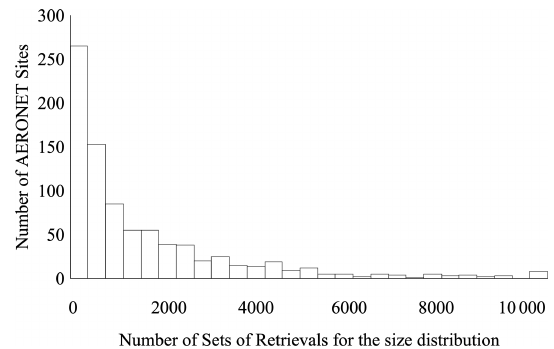
Figure 4. Number of sets of retrieval frequency for the size distri-